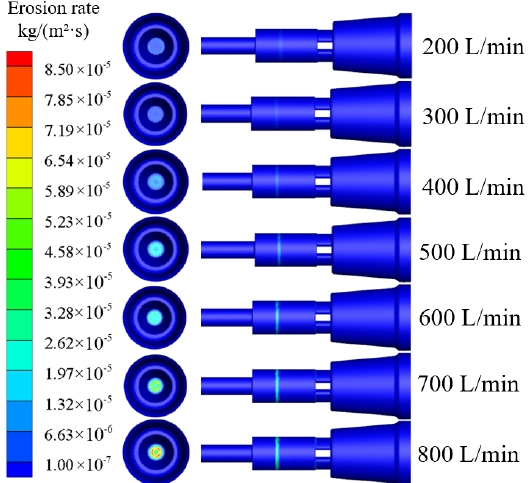
Figure 5. The maximum erosion rate changes with drilling fluid flow.